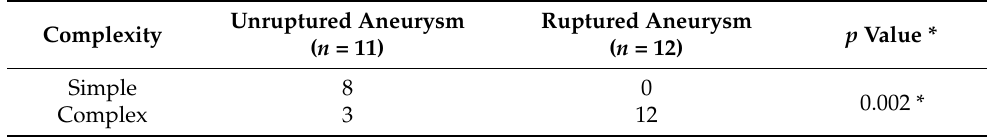
Figure 4. Simulated flow streamlines of ruptured aneurysms showing flow complexity at end-diastole. The black arrow indicates the recirculation region of the aneurysm. RU: ruptured aneurysm. Table 4. Quantification of hemodynamic variables.